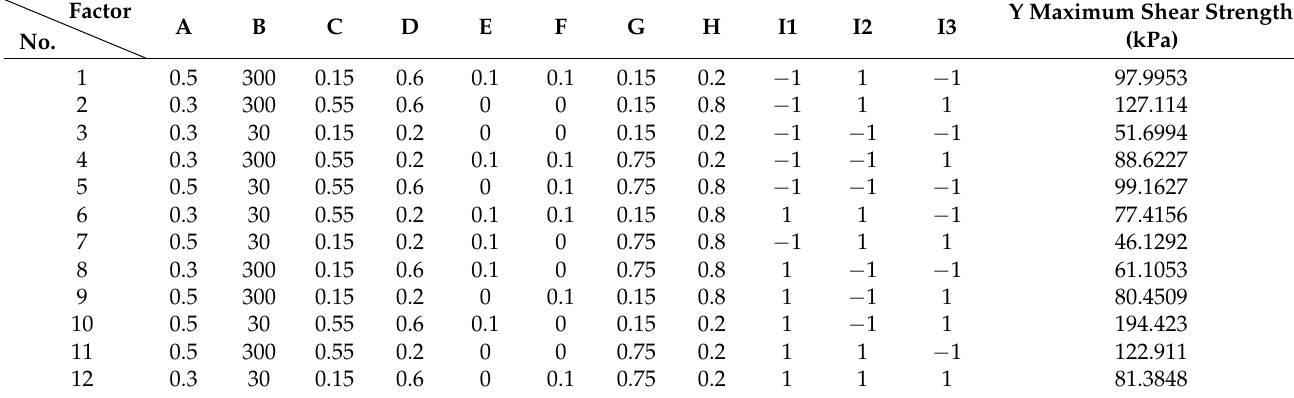
Table 8. Arrangement and results of the Plackett–Burman